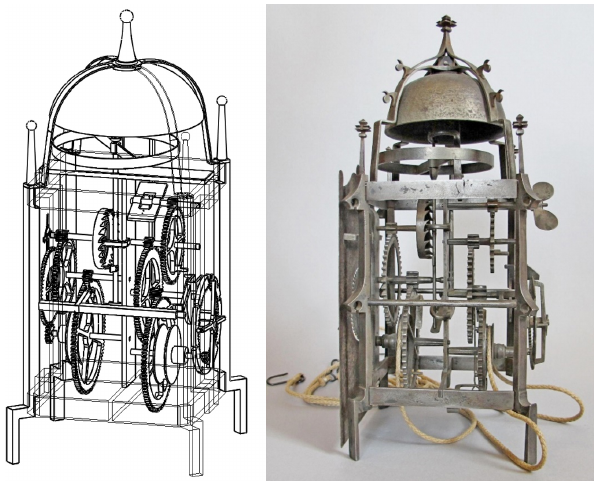
Figure 10. N3 – European iron Gothic clock (British Museum, 2020g).